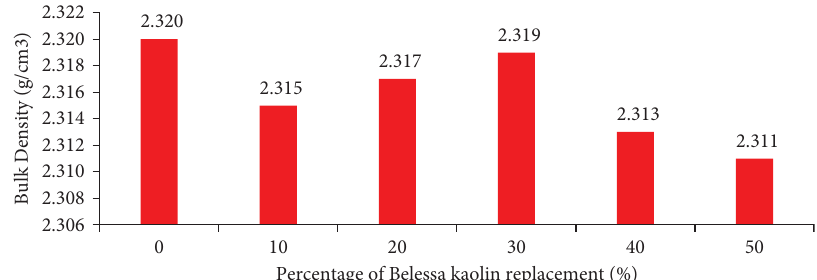
Figure 12: Relationship between bulk density and replacement rate of Belessa kaolin at OBC.